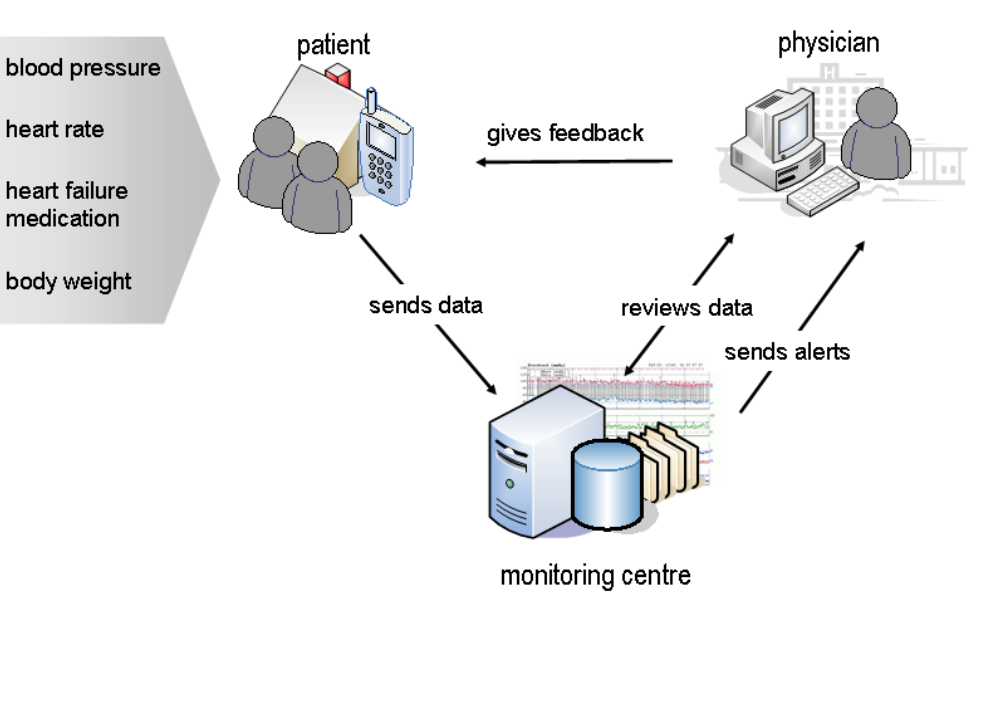
Figure 1. Schematic depiction of the equipment and data collection process used in